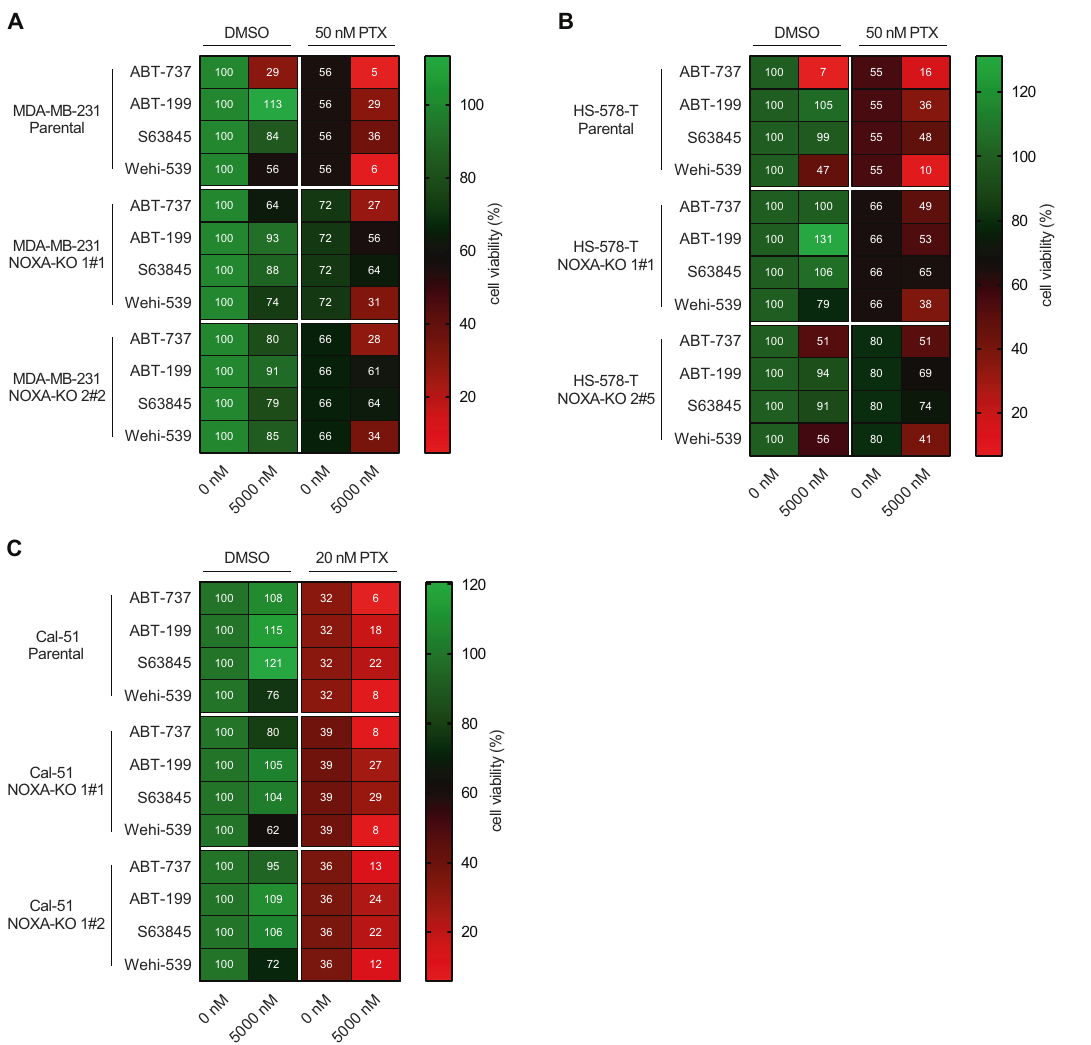
Fig. 6 NOXA deletion protects TNBC from PTX and BH3-mimetic co-treatment. Parental and two NOXA-KO clones of each TNBC cell line were treated with or without 5000 nM of the indicated BH3-mimetics alone (DMSO) or in combination with 20 or 50 nM PTX for 48 h. Heatmaps are showing the mean value of metabolic activity assessed with MTT-assay. A MDA-MB-231 ( n = 5), B HS-578-T ( n = 4), C Cal-51 ( n =